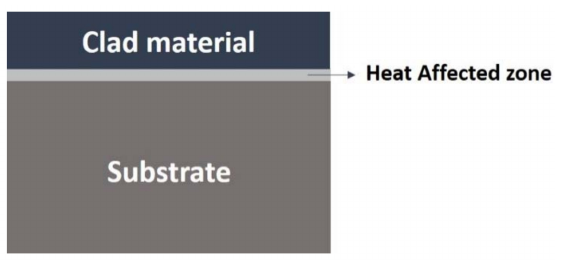
Figure 3. Identification of the substrate, heat-affected zone (HAZ), and clad